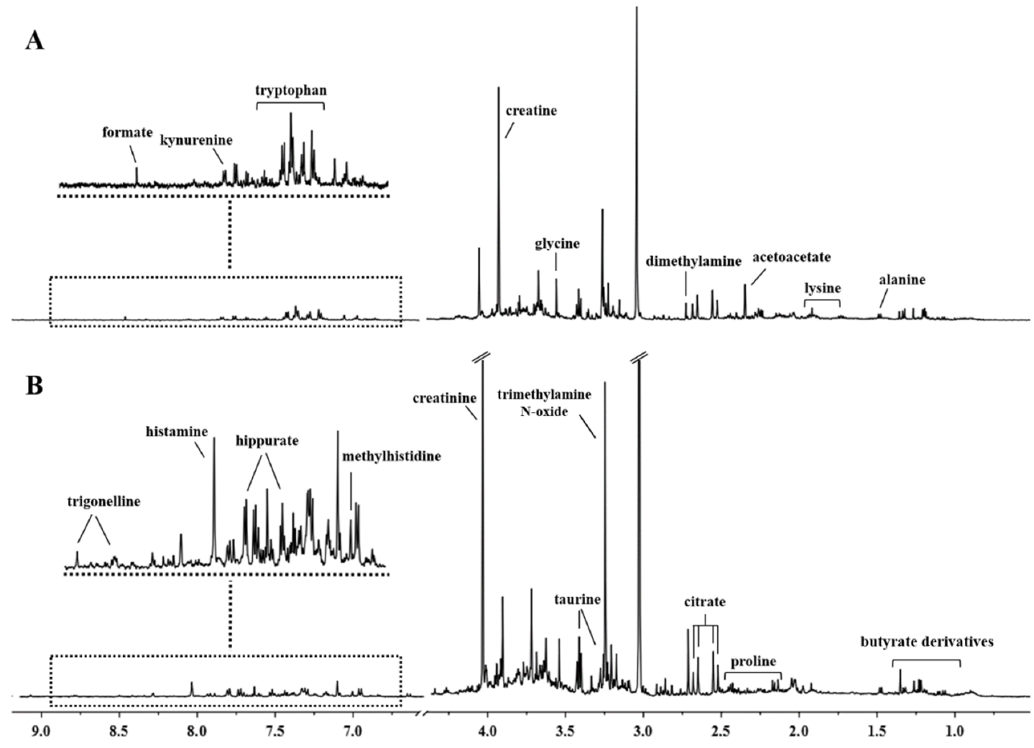
Figure 1. Spectral area and major peak assignments of a representative 1 H-NMR spectra of urine obtained from unaffected subjects (C) ( A ) or colorectal cancer patients (CRC) ( B ).